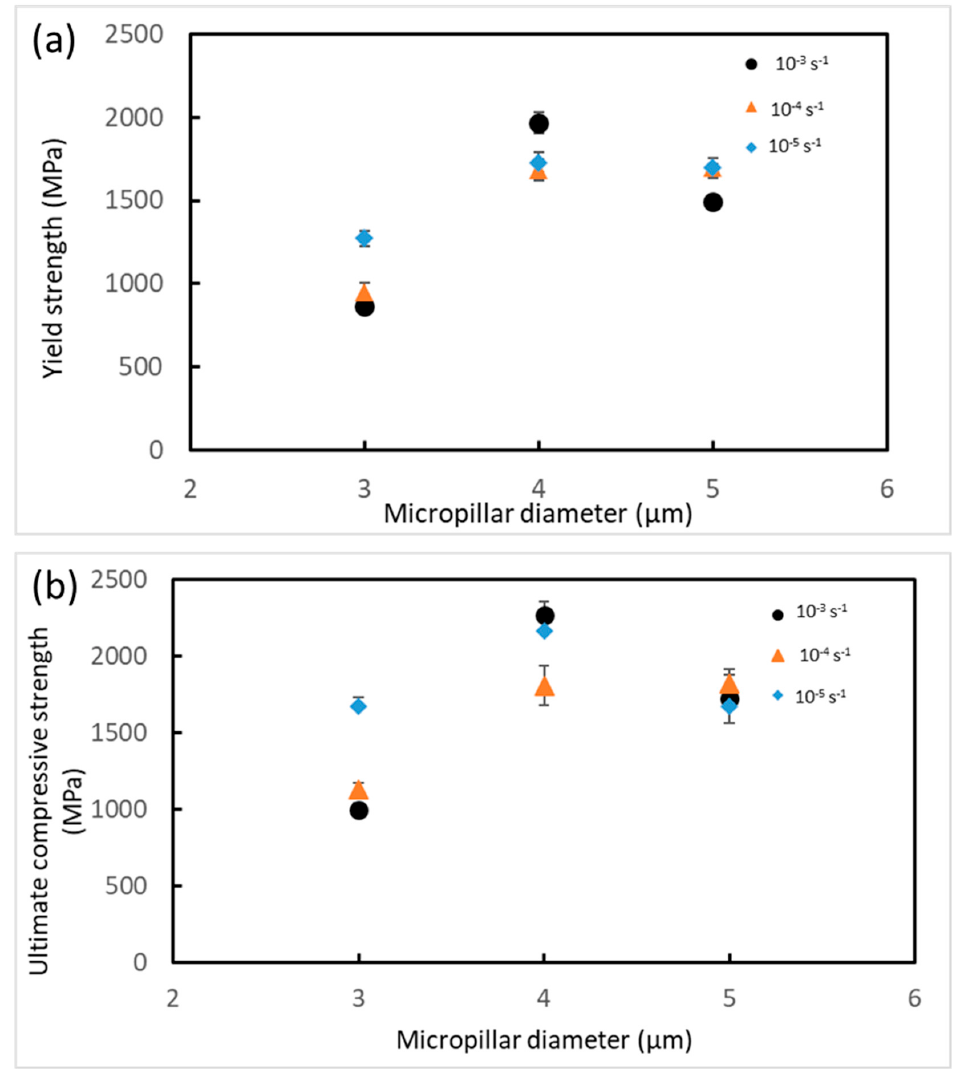
Figure 6. Compression of ( a ) the yield strength and ( b ) the ultimate tensile strength, in terms of micro-pillar diameter and strain rate.